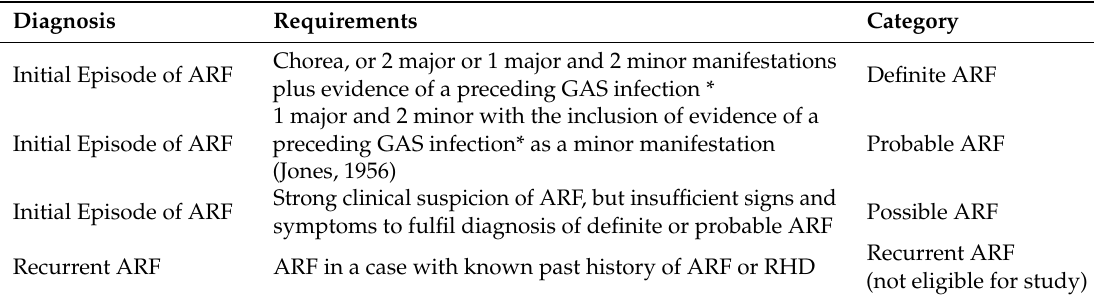
Table 1. Categories of acute rheumatic fever (ARF)—New Zealand (NZ)-modified version of the Jones